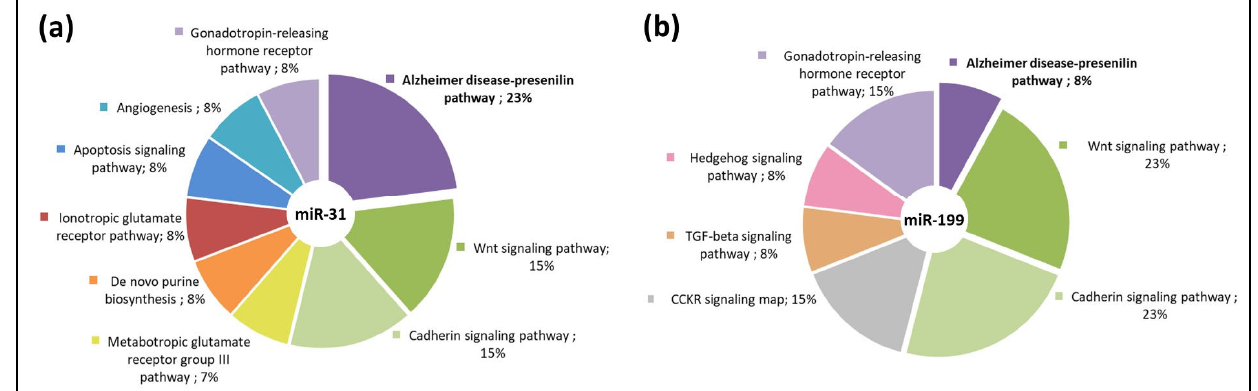
Figure 4. Bioinformatic analysis of predicted miR-31 and miR-199 target genes. Gene ontology analysis using the Panther software showing enriched pathways for miR-31 predicted target genes ( a ) and miR-199 predicted target genes ( b ).